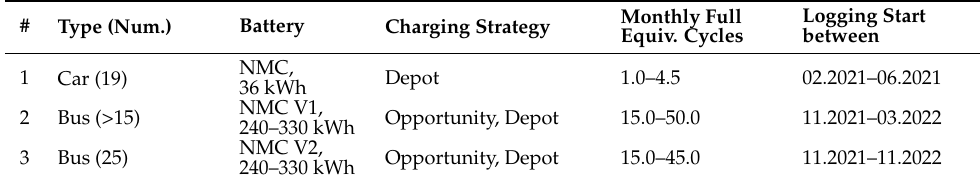
Table 1. Overview of available fleet